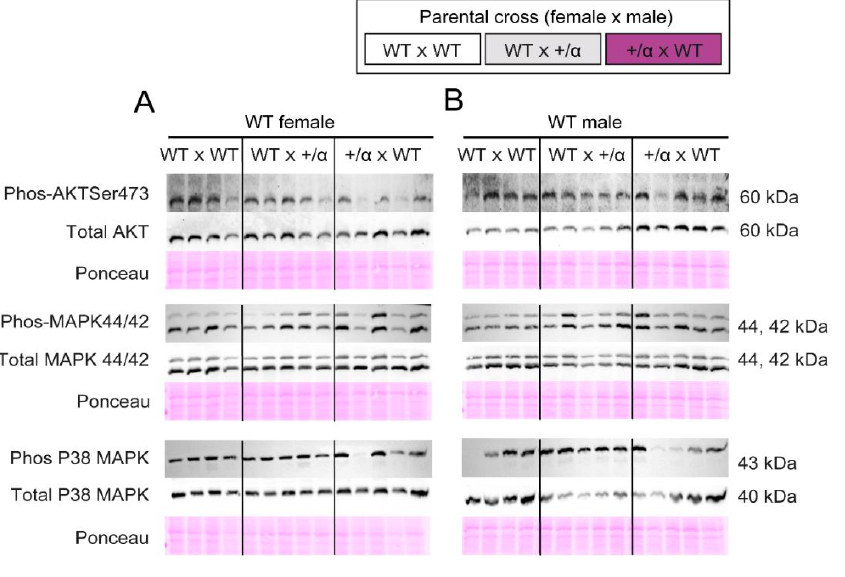
Figure 5. Abundance of growth and metabolic signalling proteins in placental labyrinth of WT conceptuses in response to littermate and/or maternal p110α deficiency. Female ( A ) and male ( B ) representative images from each antibody immunodetection and Ponceau staining for phosphor- ylated and total AKT, AMPKα, MAPK 44/42 , and P38 MAPK. Total AKT, AMPKα, MAPK 44/42 , and P38 MAPK protein levels in females and males ( C ), and AKT, AMPKα, MAPK 44/42 , and P38 MAPK phosphorylation levels as a ratio to total protein in females and males ( D ). Data are from 1 WT fetus per dam generated by WT x WT ( n = 4 ), WT x α/+ ( n = 5), and α/+ x WT ( n = 5) parental crosses and are displayed as individual data points with mean ± S.E.M. Data were analysed by one-way ANOVA with Tukey post hoc pairwise comparisons (* p < 0.05, ** p < 0.01, *** p < 0.001, **** p < 0.0001, pairwise comparison). p = phosphorylated, t = total. 4. Discussion Using genetic disruption of p110α signalling as a tool, we demonstrate d the im- portant influence of the maternal and intrauterine environments on feto-placental growth and placental mitochondrial respiration/metabolism. Specifically, by comparing to pregnancies where both the mother and all fetuses are WT, placental LZ respiratory ca- pacity of WT fetuses of both sexes varied when either littermates and/or the mother was